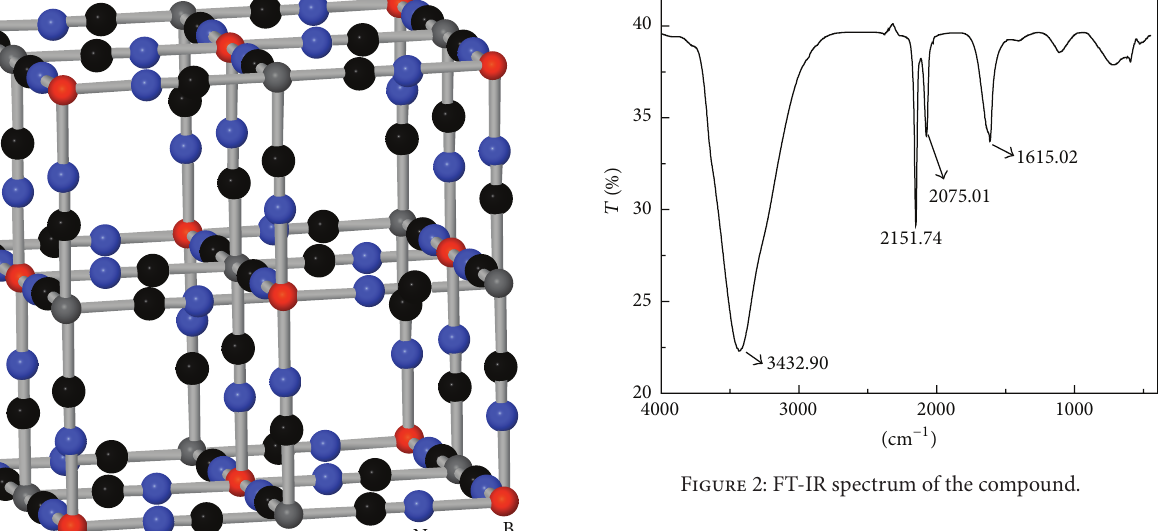
Figure 1: Structure of Prussian blue analog A